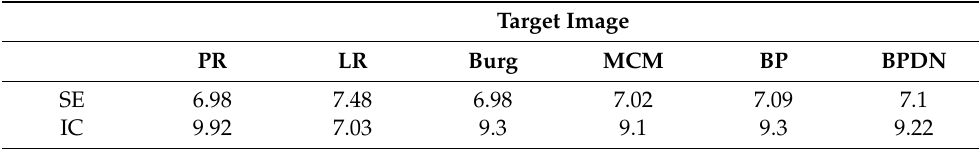
Table 3. SEs and ICs of target images of extended static target.